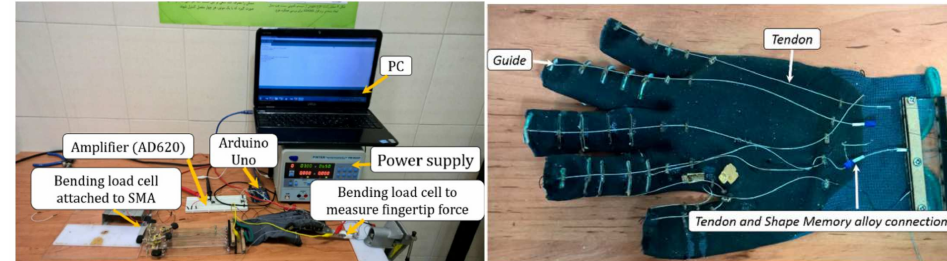
Figure 12. Experimental prototype of the wearable glove driven by shape memory alloy